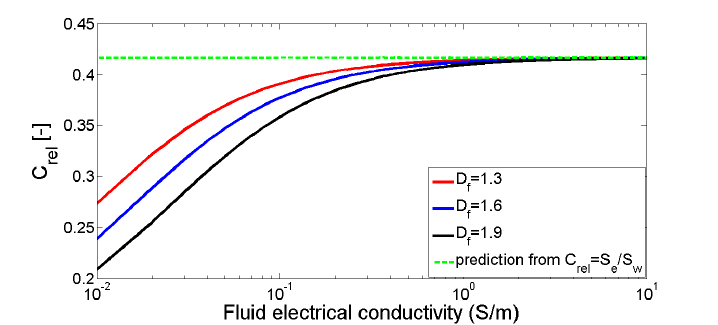
Figure 3. The variation of the relative SPCC with fluid electrical conductivity predicted from Equation (29) for three values of D : 1.3, 1.6, and 1.9 (see the solid lines) with Σ s = 10 × 10 − 9 S, S wirr = 0.2, S w = 0.3, r max = 50.10 − 6 m and α = 0.01. The dashed line is predicted from Equation